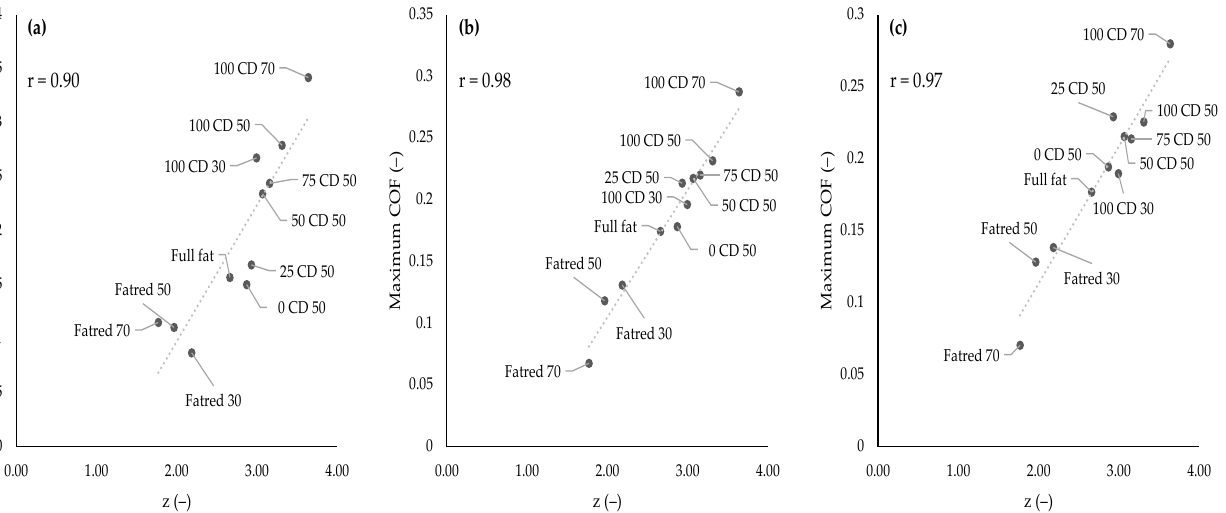
Figure A2. Correlations between the interaction factor z and the maximum COF of curve 1 ( a ), curve 2 ( b ), and curve 3 ( c ) (r = correlation coefficient).